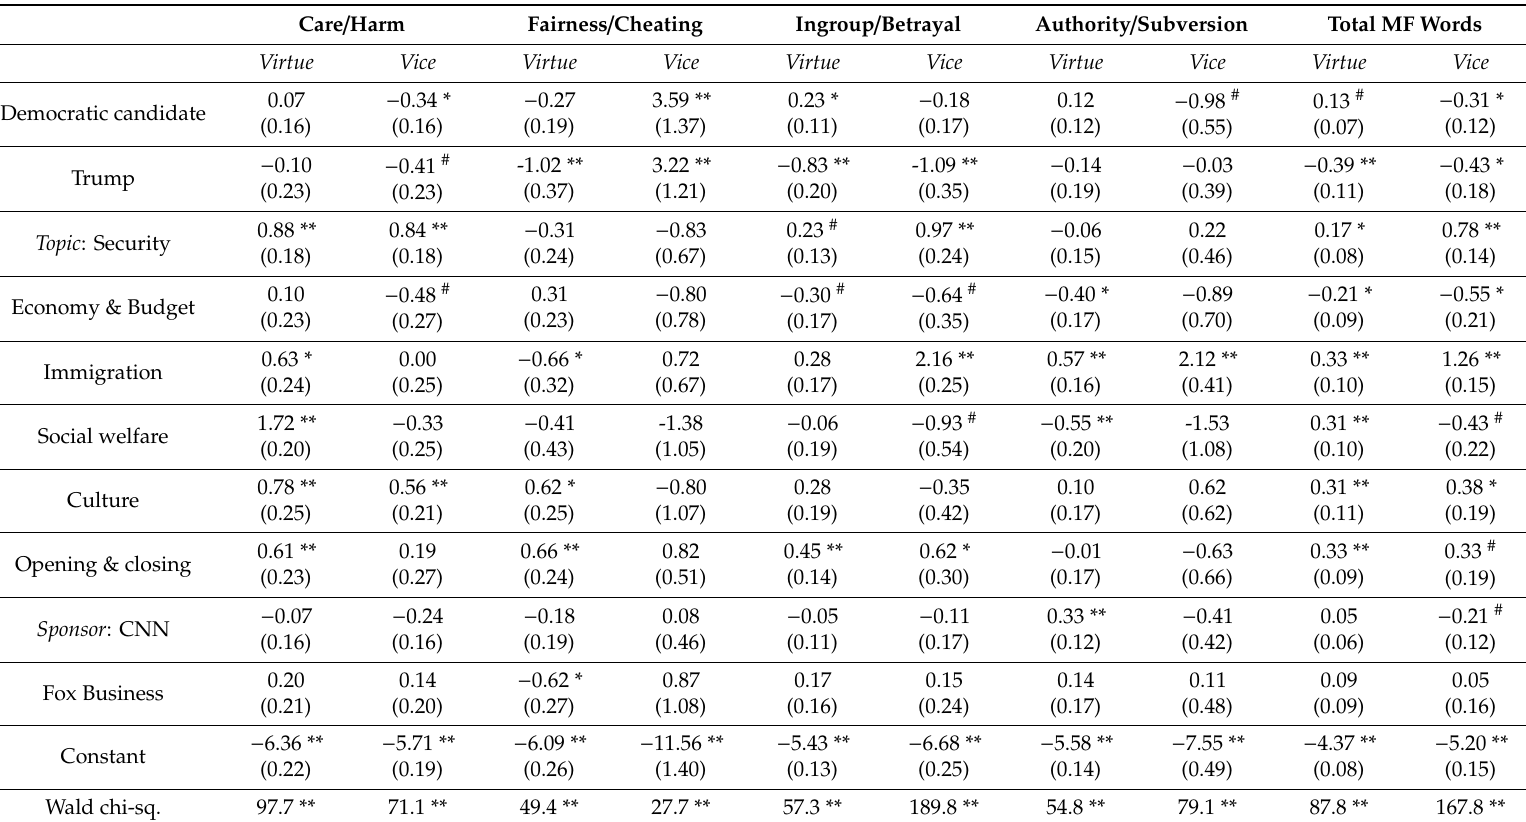
Table A1. Negative binomial regressions estimating the number of moral-foundations words